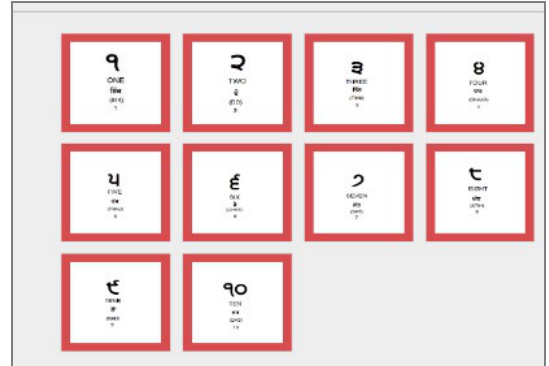
Figure 3(b). List of words after selecting counting